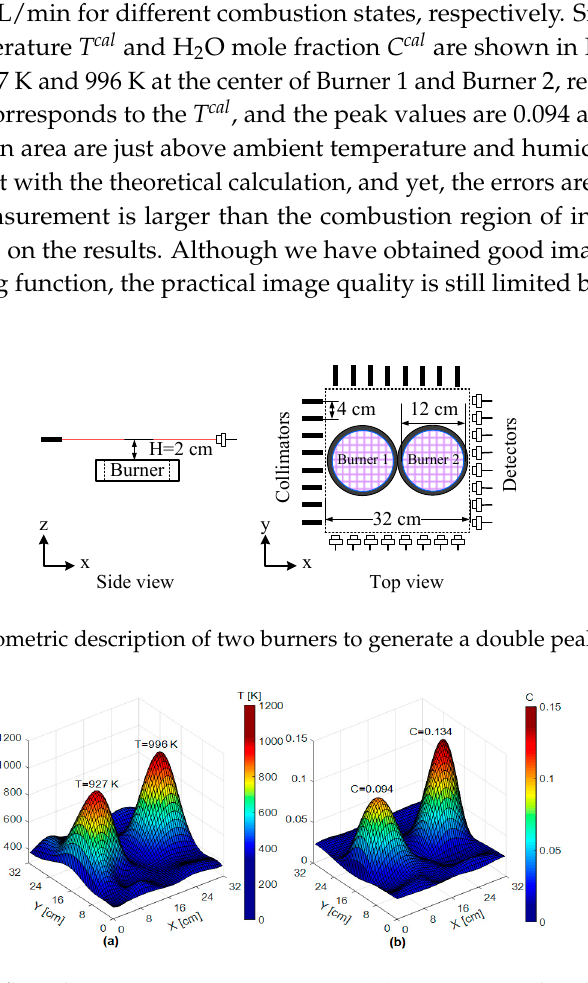
Figure 14. Double flat flame burner reconstruction images. ( a ) Temperature distribution and ( b ) H 2 O concentration distribution.